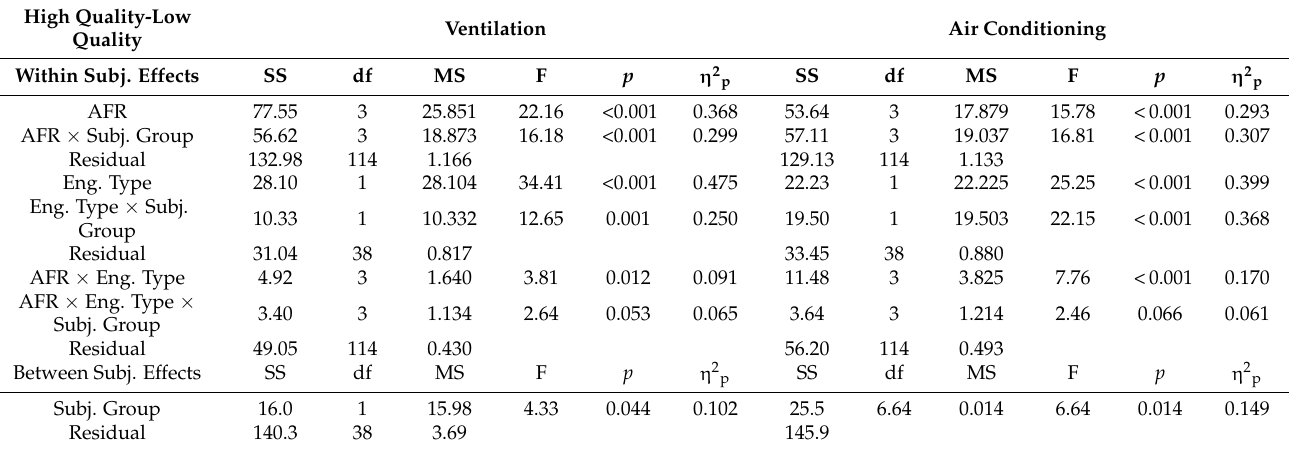
Table 2. ANOVA results for High Quality-Low Quality .